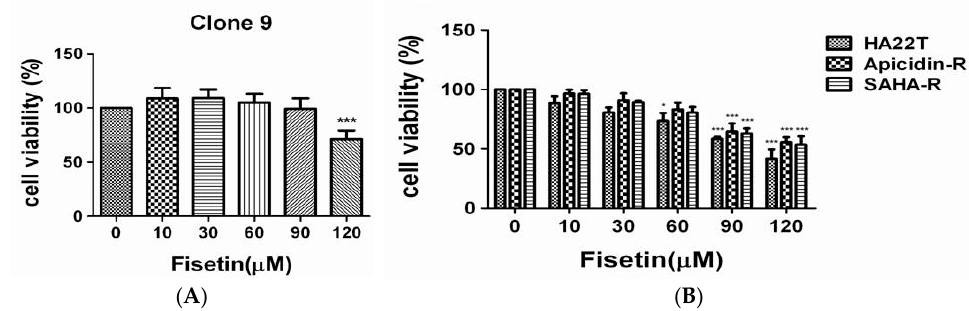
Figure 1. The effect of fisetin on normal cell and hepatocellular carcinoma cell viability. To explore the effect of fisetin on human liver cancer cell viability, we first treated normal cells (Clone 9 cells) and liver cancer cells (HA22T, AR, SR cells) with various concentrations of fisetin (10, 30, 60, 90, and 120 µ M)